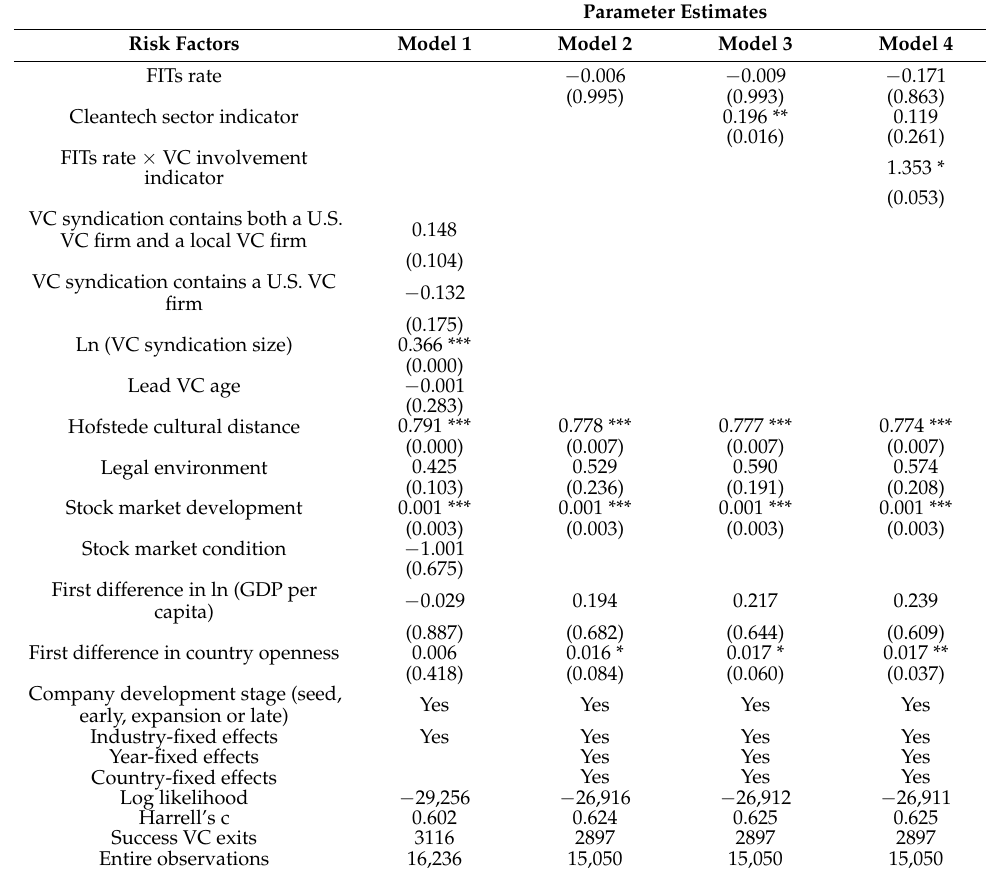
Table 3. Cont. (C) Cox Hazard Analysis of 15,582 VC-Backed Cleantech and VC-Backed Non-cleantech